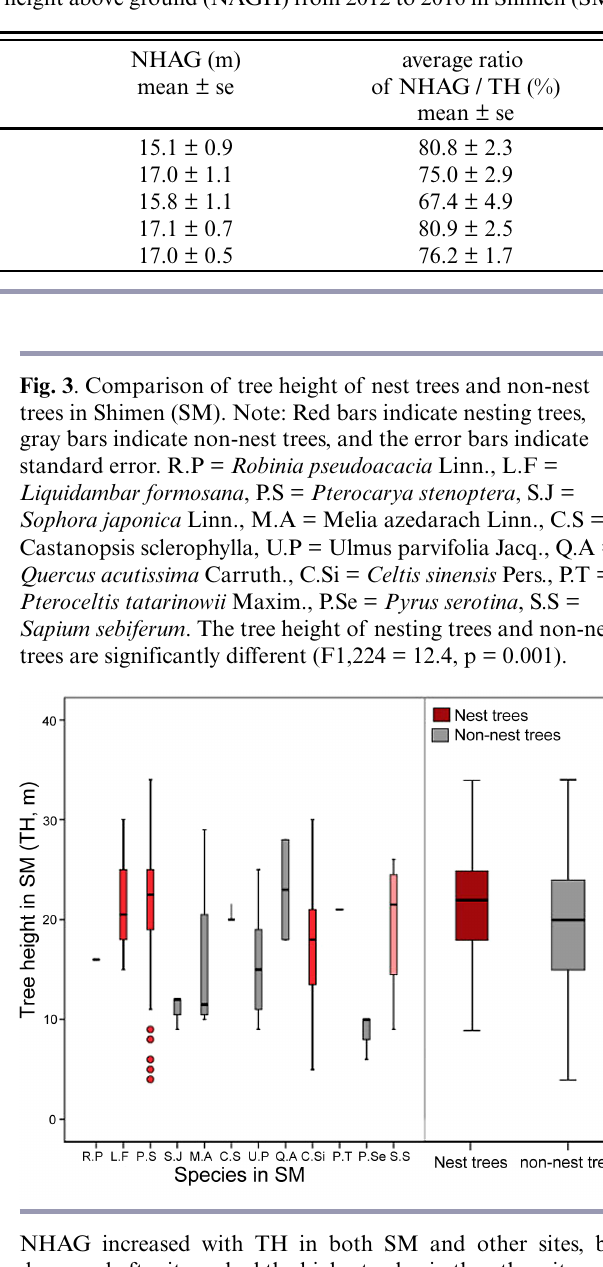
Table 2 . Linear-regression analysis of the tree height (TH) and nest height above ground (NAGH) from 2012 to 2016 in Shimen (SM).